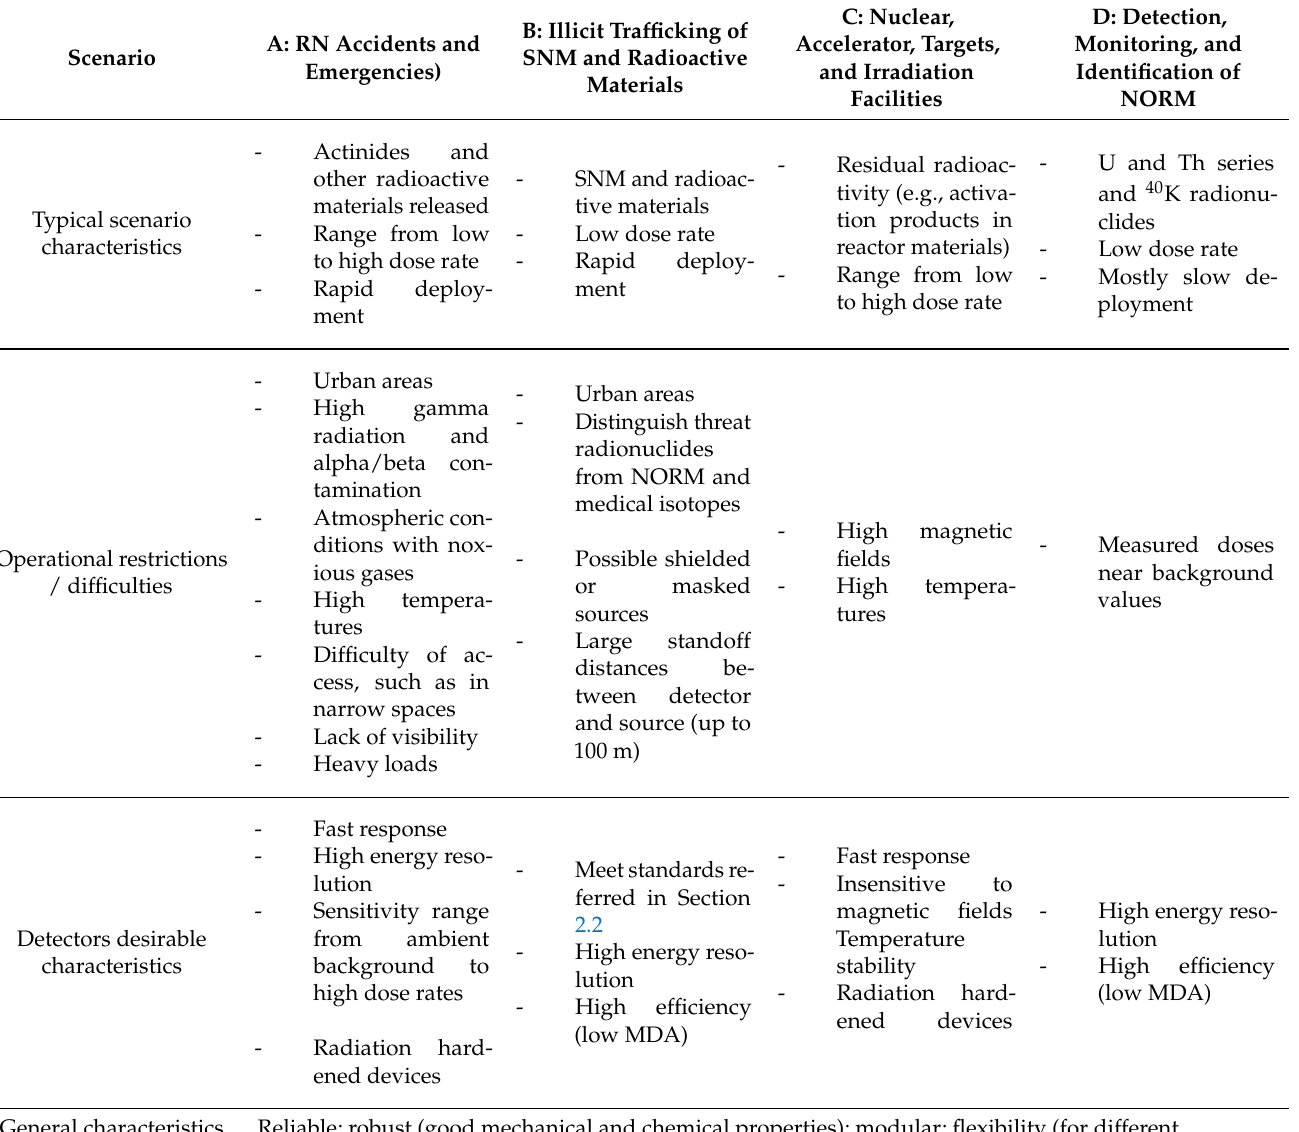
Table 6. Summary of the typical scenario characteristics and detection system performance